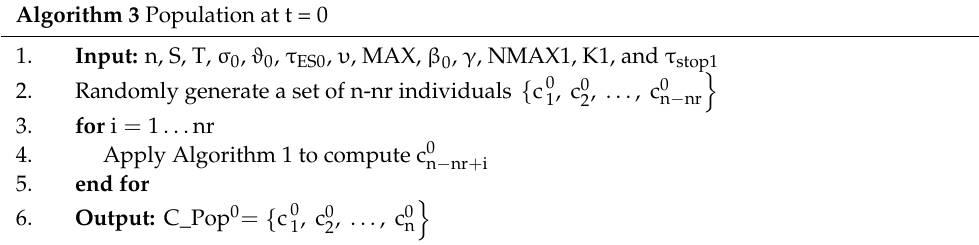
Algorithm 3 Population at t =